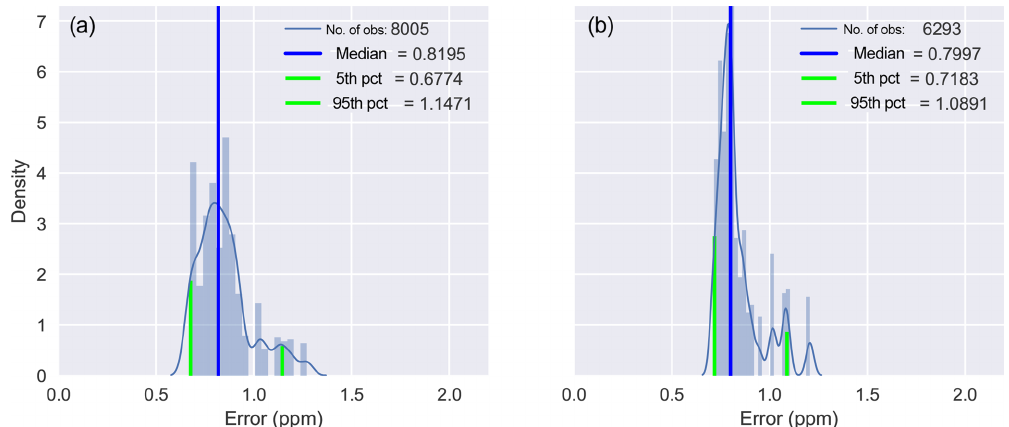
Figure 15. The algorithm-selected strategy (a) has approximately 2000 more usable observations than the baseline strategy (b) in the city campaign mode.